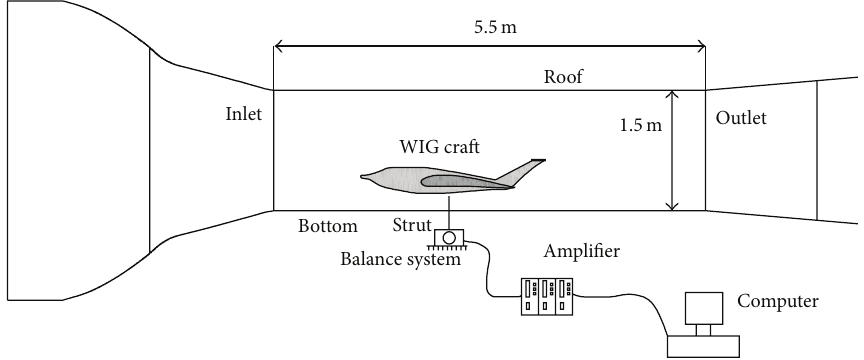
Figure 5: Experimental setup in the wind tunnel at the Universiti Teknologi